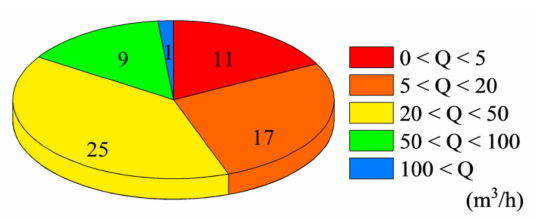
Figure 7. Number of boreholes with different water inflows ( Q